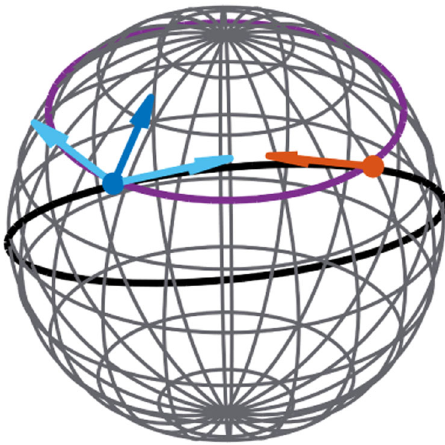
Fig. 4 Positions and velocities in a two-agent system on the sphere S 2 . One agent has clockwise drift around the z -axis (blue dot) and the other agent is without drift (red dot). The two agents are situated at the same latitude (purple circle). However, the coupling terms in the dynamics are tangent to the great circle connecting both agents (black). The dark blue vector is the sum of light blue vectors. The time derivatives of both agents (dark blue and red arrows) are pointing north of the latitude on which the agents lie. Hence, the latitudes are